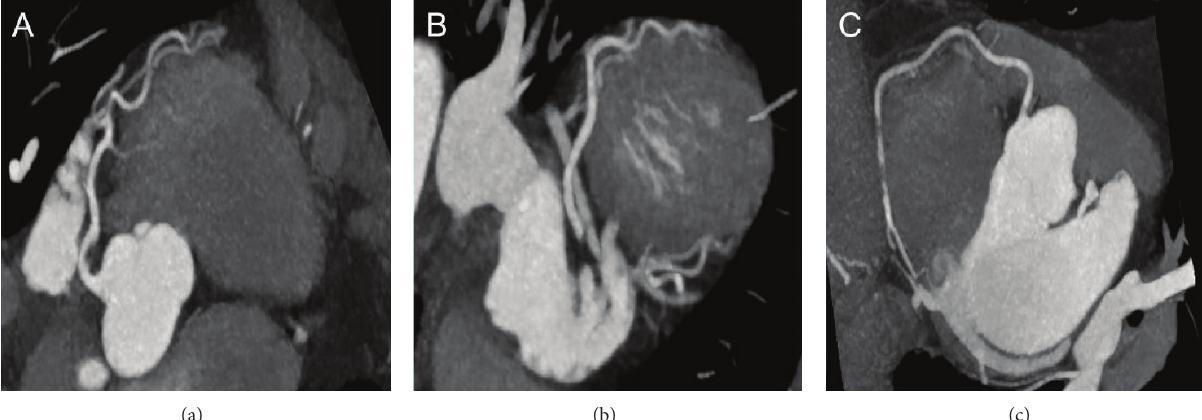
Figure 3: Coronary computed tomography showing absence of coronary artery calcium, with no evidence of arteriosclerotic